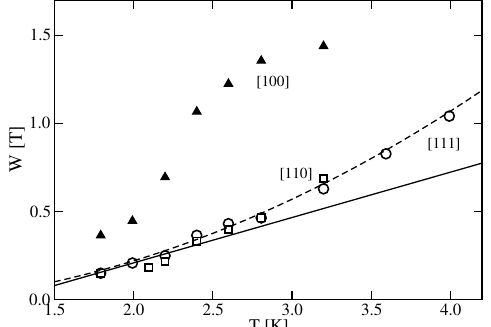
Figure 5. Line width W of CeB 6 as a function of temperature for the three principal axis from Ref. [44]: The dark triangles correspond to [100], the open squares to [110] and the open circles to [111]. The straight line represents a Korringa relaxation for intermediate T and the [110] and [111] directions. The dashed line is a parabolic